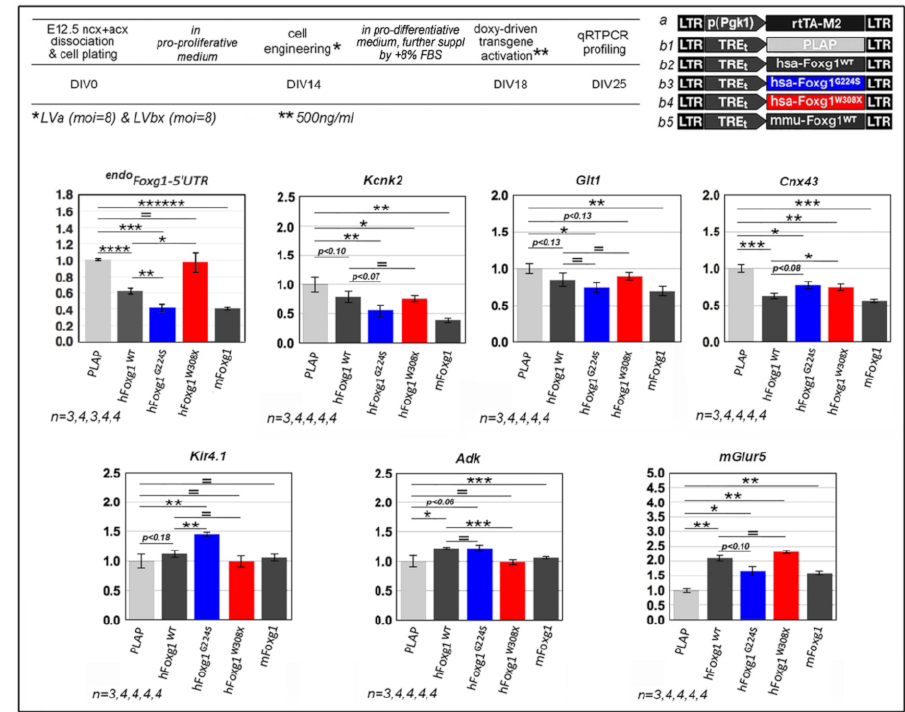
Figure 7. Impact of mutant FOXG1 alleles on astroglial transcriptome, upon lentiviral delivery of transgenes encoding for them to wild-type , murine astroglial cultures. Top: protocols and lentiviral vectors employed; bottom: qRTPCR results. Data normalized against Plap -expressing